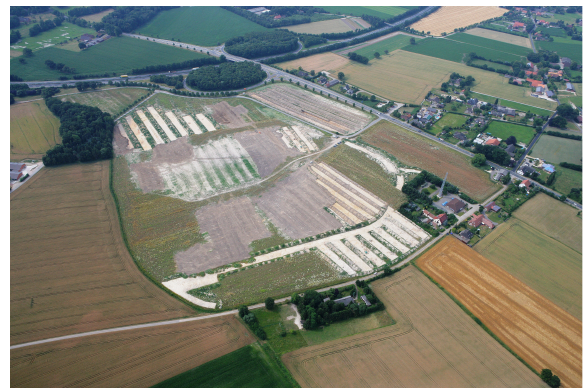
Figure 11: Profile view of a potential finding on Ganderkesse excavation site in Germany.